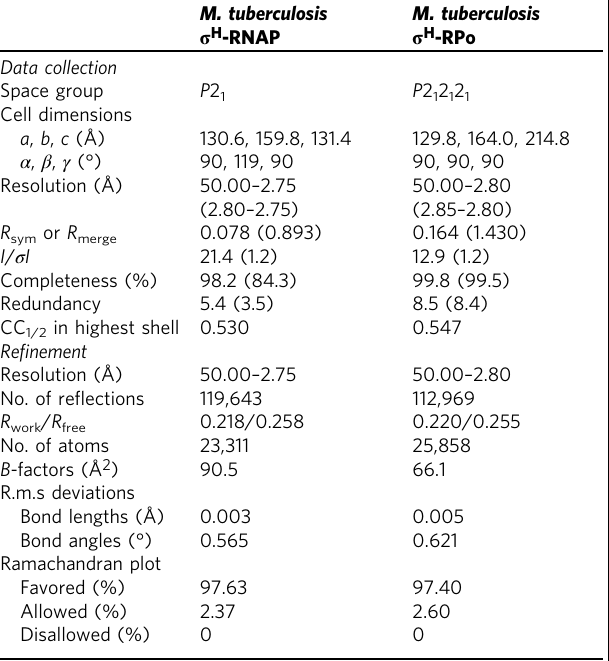
Table 1 The statistics of crystal